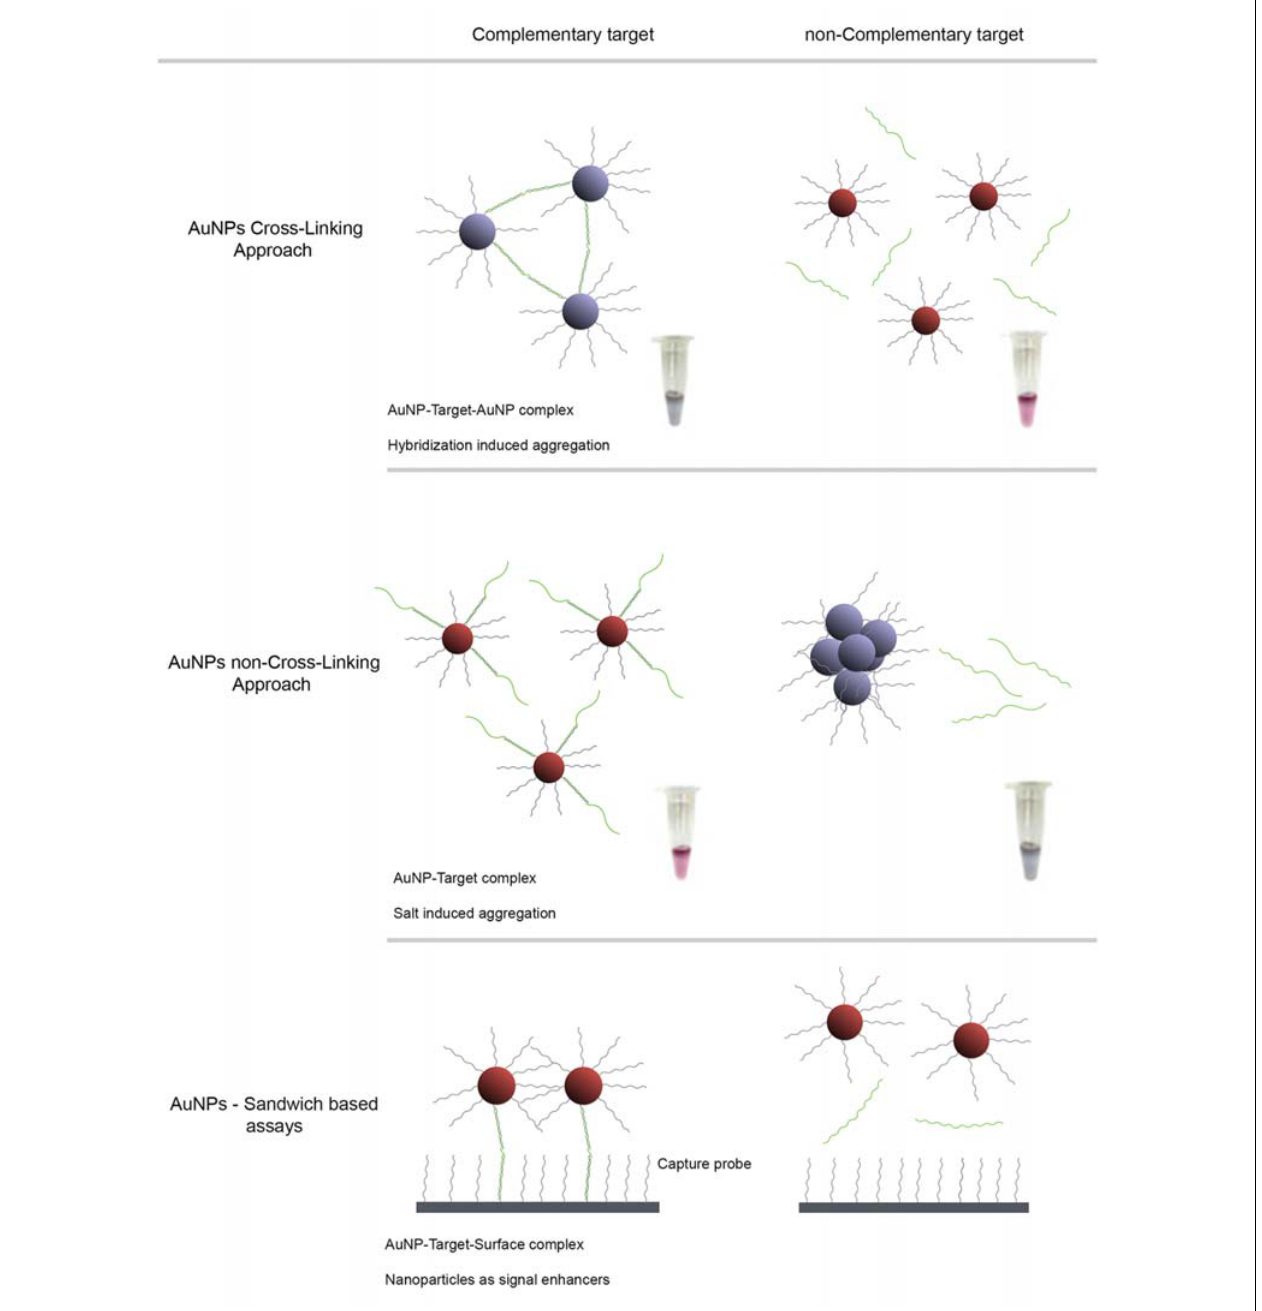
the presence or absence of the specific target sequence: presence of the complementary target sequence to that of the probe prevents aggregation and the solution remains red, whereas absence of a specific target sequence leads to extensive aggregation after salt addition and the solution turns blue. (C) Sandwich based assay involves an immobilized capture probe, target DNA and one Au-nanoprobe reporter. Half of the target DNA hybridizes to the immobilized DNA and the other half to the reporter Au-nanoprobe.This strategy allows a simple to preform surface wash, thus increasing the signal to noise ratio and consequently the sensitivity.This method enables a higher sensitivity when coupled to an improved hybridization method that facilitates probe-target binding in a homogeneous